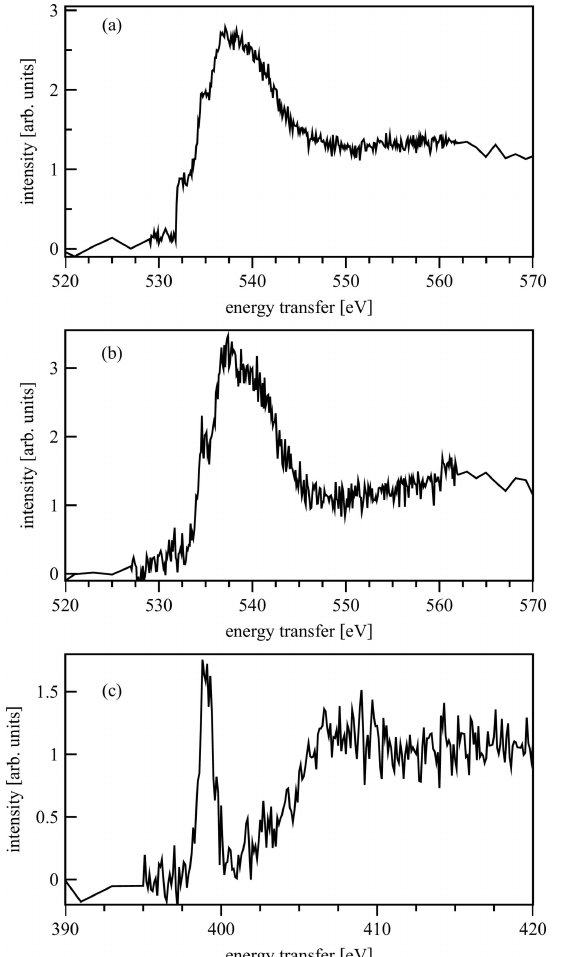
Figure 19 O K -edge spectra of isopropanol ( a ) and water ( b ). N K -edge spectrum of n -Pr-BTP ( c